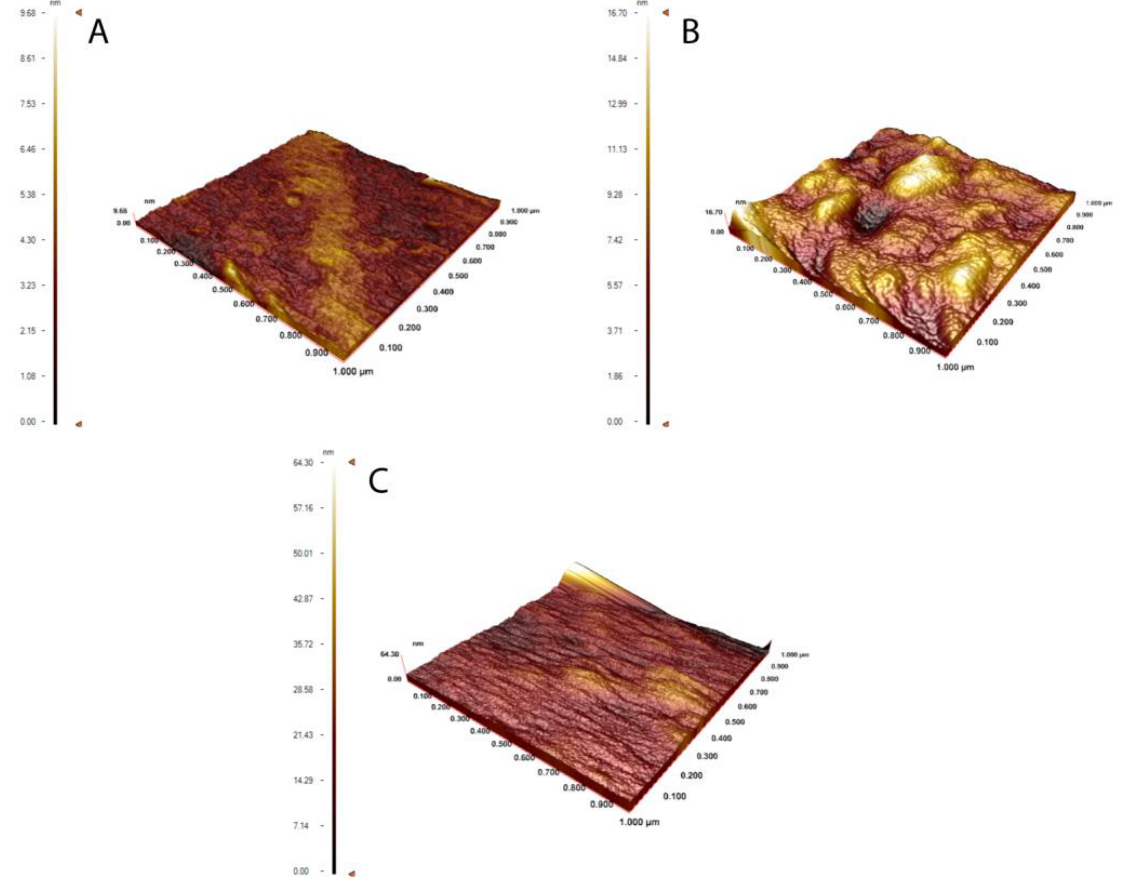
Figure 2. AFM Images; ( A ) bare SPR chip, ( B ) ally-modified SPR chip, and ( C ) CIP-SPR nanosen- sor.